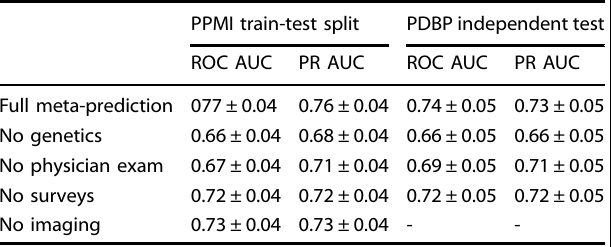
Fig. 5 Distribution of polygenic scores in relation to MDS-UPDRS subpart and total progression. Distribution of polygenic scores for Parkinson ’ s disease diagnosis (left column) and Educational attainment (right column), by MDS-UPDRS subparts and Total progressors (red) and non-progressors (blue). Distribution overlaps are colored purple. The Parkinson ’ s disease PRS has a right tail that is more prominent in non-progressors, likely capturing a genetic subgroup of Parkinson ’ s disease due to high polygenic risk. The Educational attainment PRS is normally distributed with a minor left shift in the distribution for motor non-progressors. Table 4. Feature component accuracy of 12-month MDS-UPDRS total